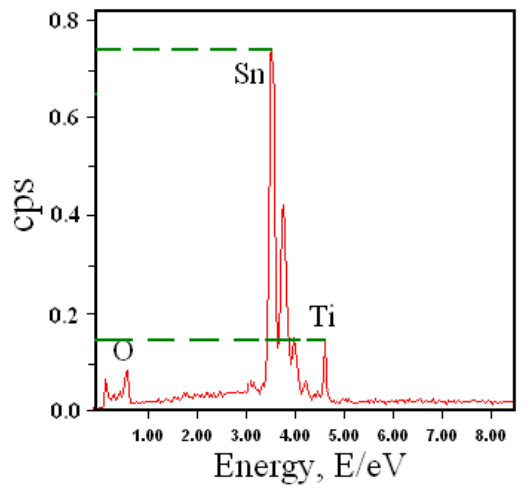
-SnO thick film. 2 2